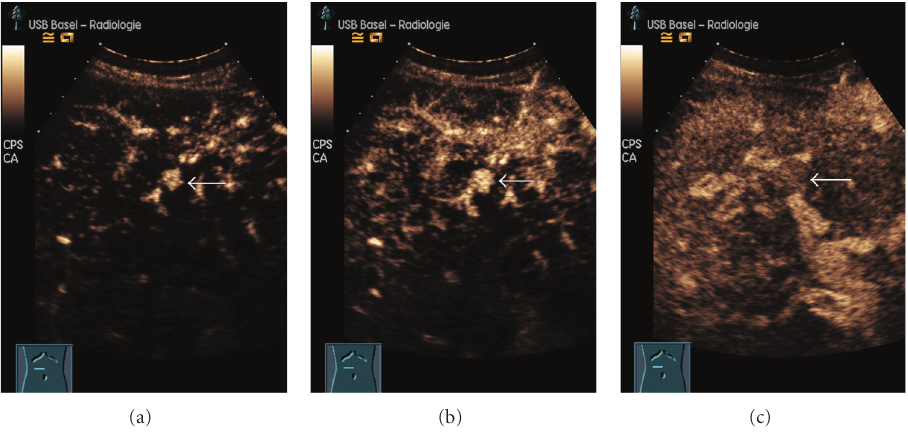
Figure 3: CEUS shows a more explicit centrifugal arterial (a) 16s p.i.; (b) (17s p.i.) and a liver like portal venous enhancement (c) (50s p.i.) of the reference lesion (arrow).